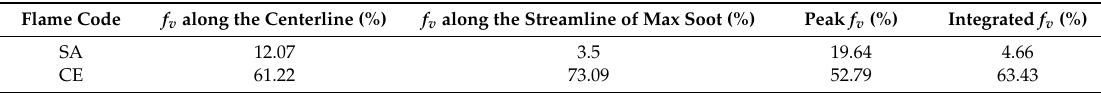
Table 4. Relative errors between the CFD and the predicted data by ANN for two flames used to test the